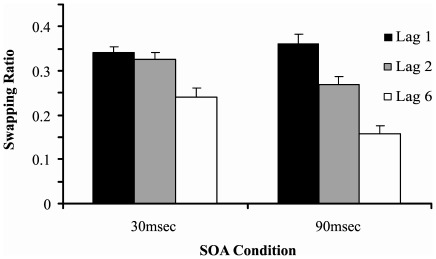
Order-error ratios across lags 1, 2 and 6 for the 30 msec SOA and 90 msec SOA conditions.The order-error ratio ranges from 0 (no order-errors) to 1 (all correctly identified targets order-error). Across both SOAs, order-errors were least frequent at lag 6. Error bars represent standard errors.